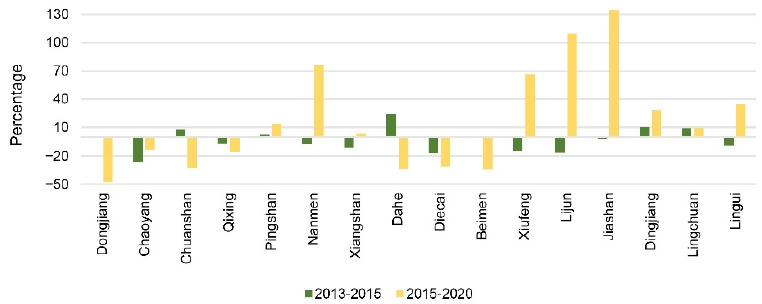
Figure 7. Changes in per capita land consumption (LCPC) from 2013 to 2020 in townships of Guilin. 5.3. Spatiotemporal Variation of Open Public Space (SDG 11.7.1) For SDG11.7.1 indicator, the land of streets in the area was 16.18 km 2 , which accounts for 5.13% of total urban area (Figure 8). The area of green space was 160.28 km 2 , 123.10 km 2 , and 59.32 km 2 in 2013, 2015 and 2020, respectively, showing a rapidly decreasing trend. The corresponding areal proportion of urban green space (POPS) accounted for 50.83%, 33.91%, and 18.81% of the urban area, respectively. The proportion of the overall open public space has gradually decreased from 55.97% in 2013 to 39.04% in 2015 and 23.95% in 2020.